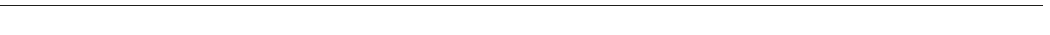
Fig. 2 LincRNA H19 required for brown but not white adipocyte differentiation and function. a Photomicrograph of BAT, scWAT, and vWAT 1° adipocytes transfected with scrambled (scr) or H19 LNAs. Pictures represent n = 6 (1°BAT) or n = 3 (others) experiments, n = 3 replicates each. Scale bar, 100 µ m b ORO staining and quanti fi cation, PGC1A/UCP1 immunoblot and quanti fi cation of 1°BAT transfected with scr or H19 LNA. Scale bar, 250 µ m. c Expression of indicated mRNAs in BAT, scWAT and vWAT 1° adipocytes transfected with scr or H19 LNAs. A paired, two-tailed Student ’ s t -test was used to assess signi fi cance across n = 3 experiments, n = 3 replicates each. d Oxygen consumption rates (OCR) in 1° adipocytes from indicated depots transfected with scr or H19 LNA. Alternating backgrounds depict medium, oligomycin, FCCP, and rotenon plus antimycin A injections. Numbers of measured wells are indicated in brackets. e OCRs in 1° adipocytes from indicated depots from H19 TG or Controls. d , e A two-way ANOVA with repeated